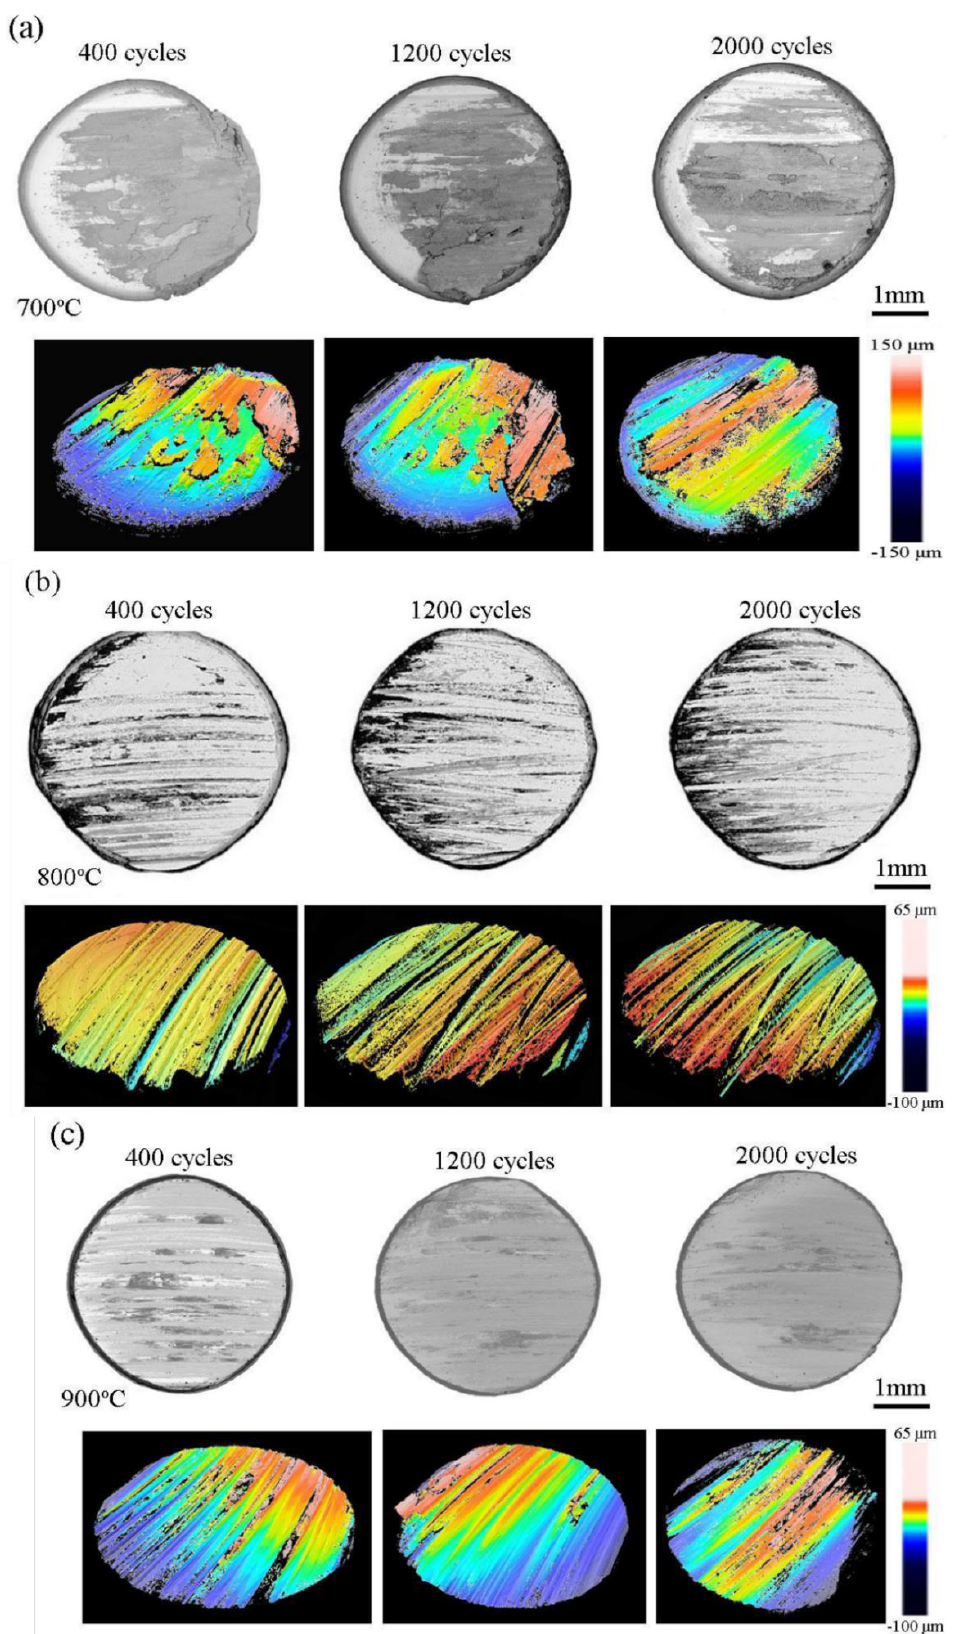
Figure 8. Topography of the pin surfaces at increasing numbers of cycles when testing at ( a ) 700 °C, ( b ) 800 °C [24], and ( c ) 900 °C.